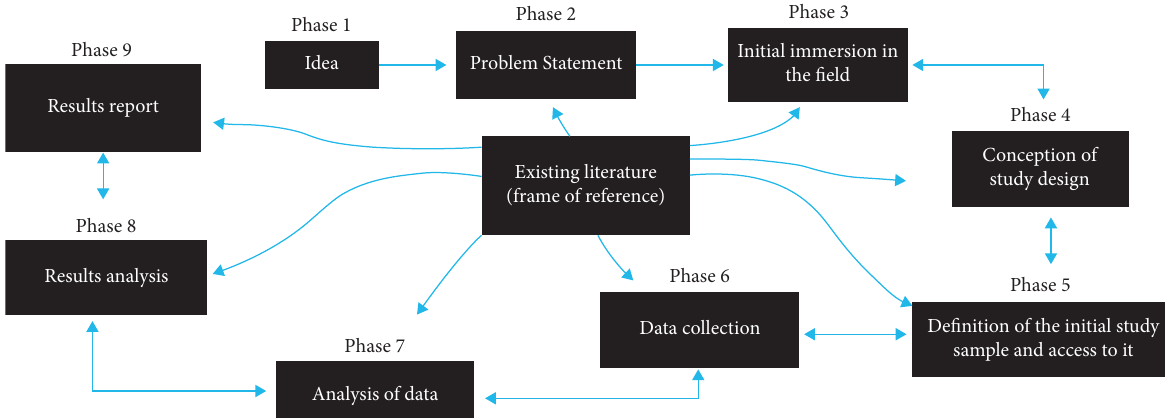
Figure 3: Qualitative research process. Source: Hern´andez, Fern´andez, and Baptista [22], p. 40.